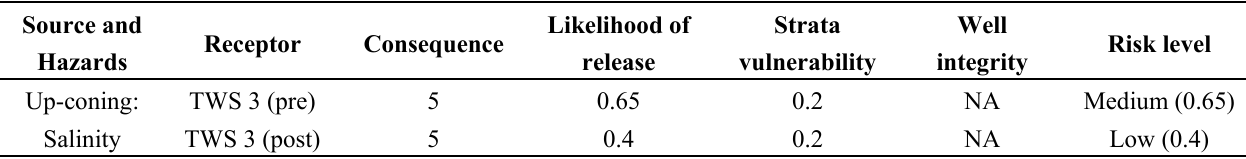
Table 7. Summary of risk assessment for TWS 3: pre- and post-implementation of an additional two production